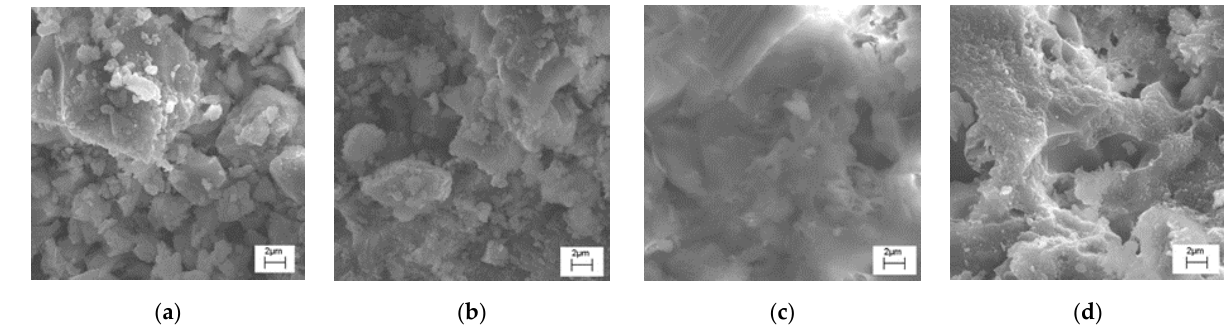
Figure 4. Micrographs of ceramics after 72 h of consolidation at temperatures of ( a ) 20 °C, ( b ) 40 °C, ( c ) 60 °C, and ( d ) 80 °C. Magnification ×6000.